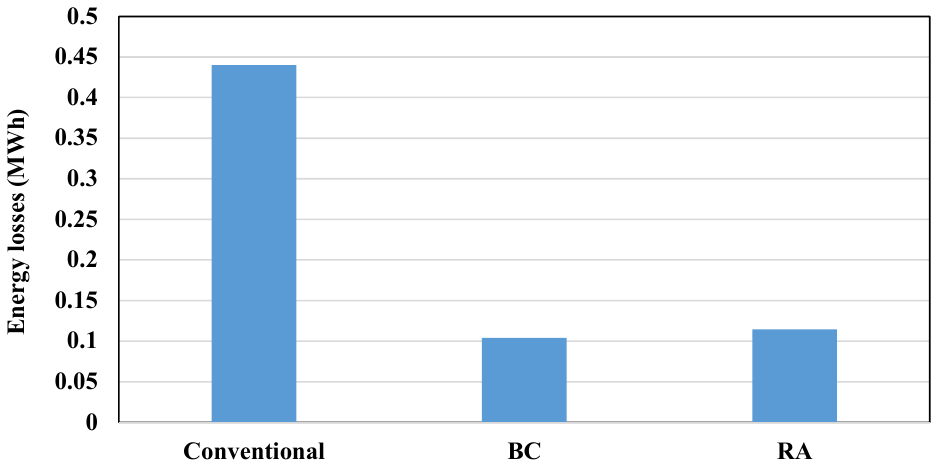
Figure 3. Energy losses in different case studies (on-grid mode).